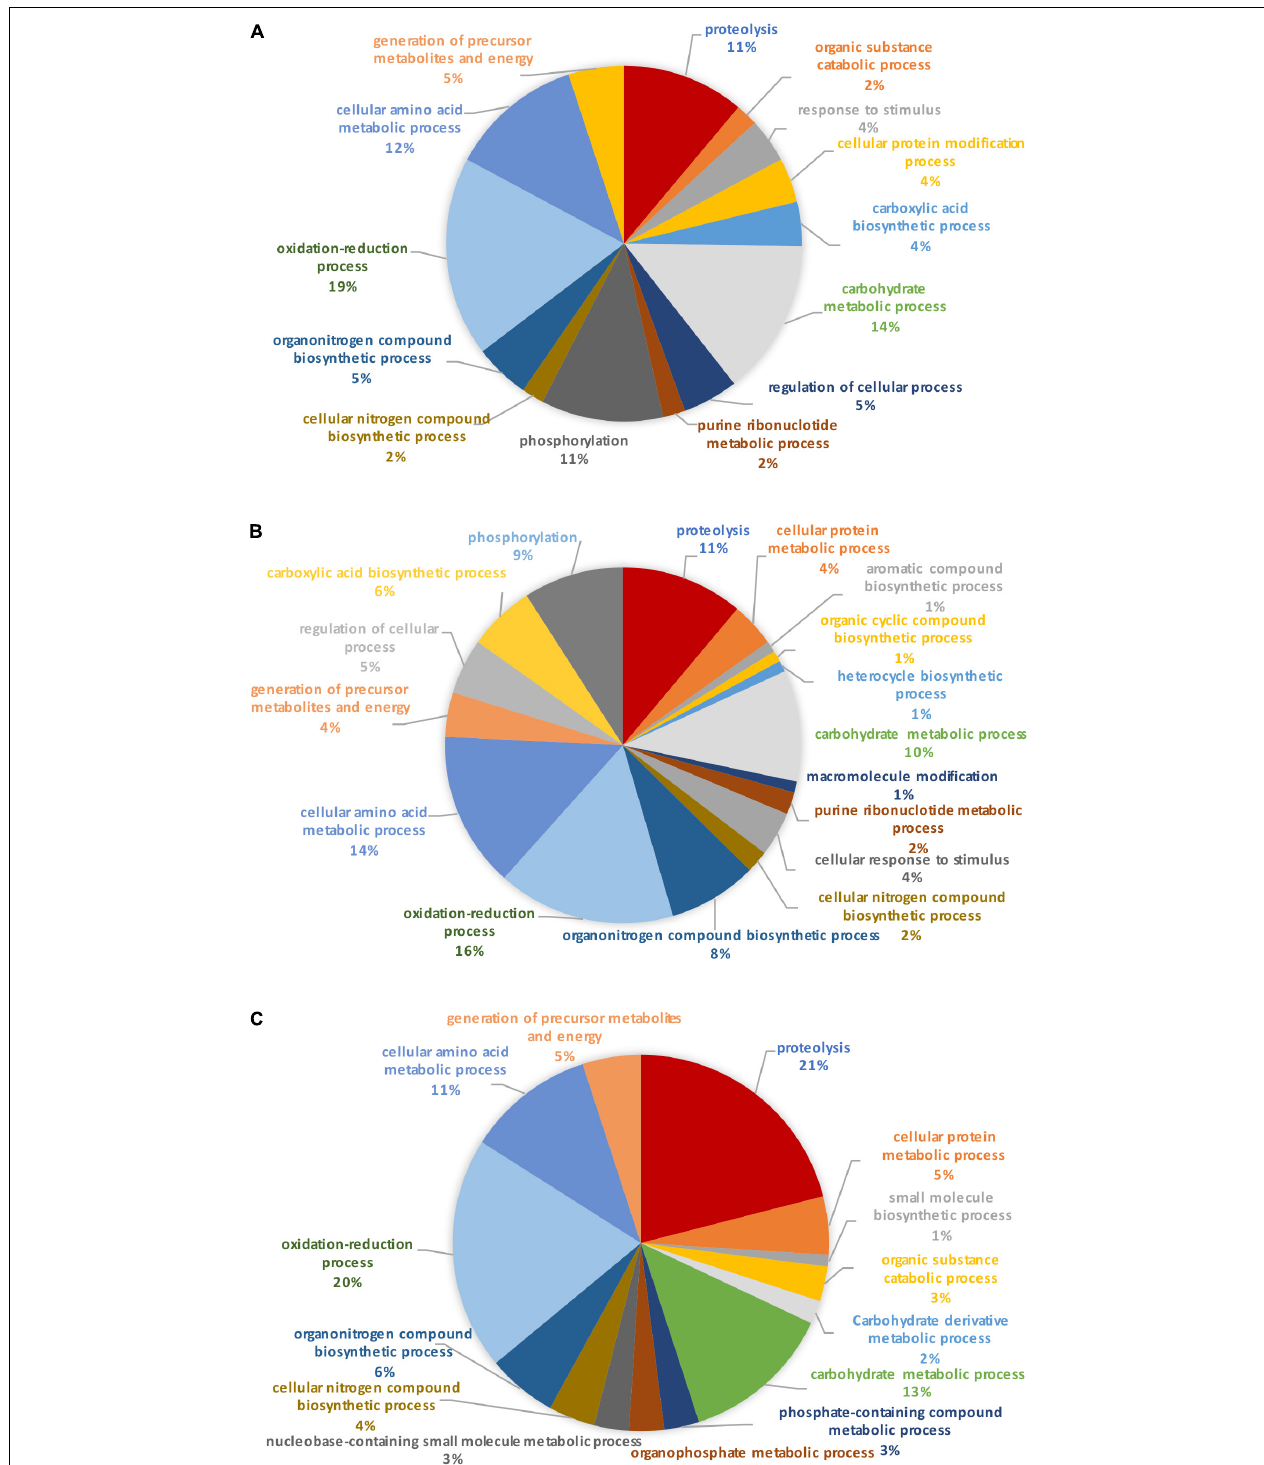
FIGURE 9 | Pie charts representing the biological process in which (A) fusiform, (B) triradiate, and (C) oval morphotype secreted proteins are involved. Pie charts are representative of 5 biological replicates. (A) Biological processes of the 275 proteins secreted in fusiform morphotype. (B) Biological processes of the 231 proteins secreted in triradiate morphotype. (C) Biological processes of the 385 proteins secreted in oval morphotype.